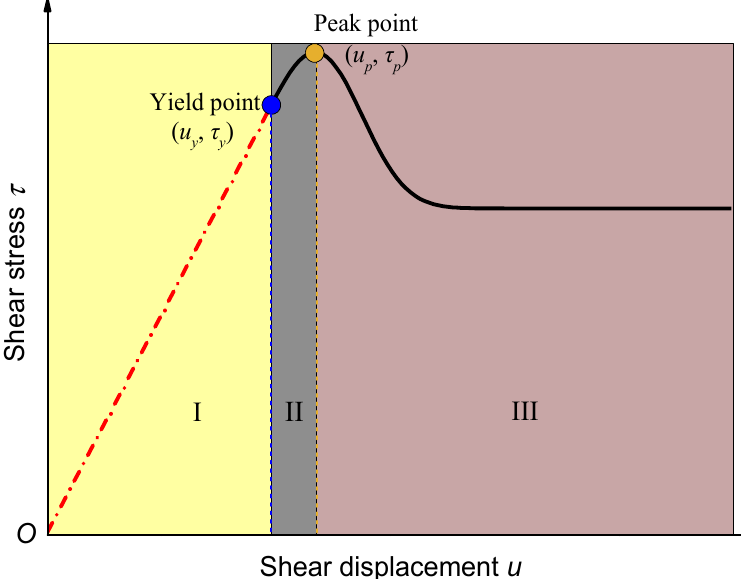
Figure 1. Schematic diagram of the shear stress–shear displacement curve ( u y and u p are yield displacement and peak shear displacement, respectively; τ y and τ p are yield stress and peak shear stress, respectively).